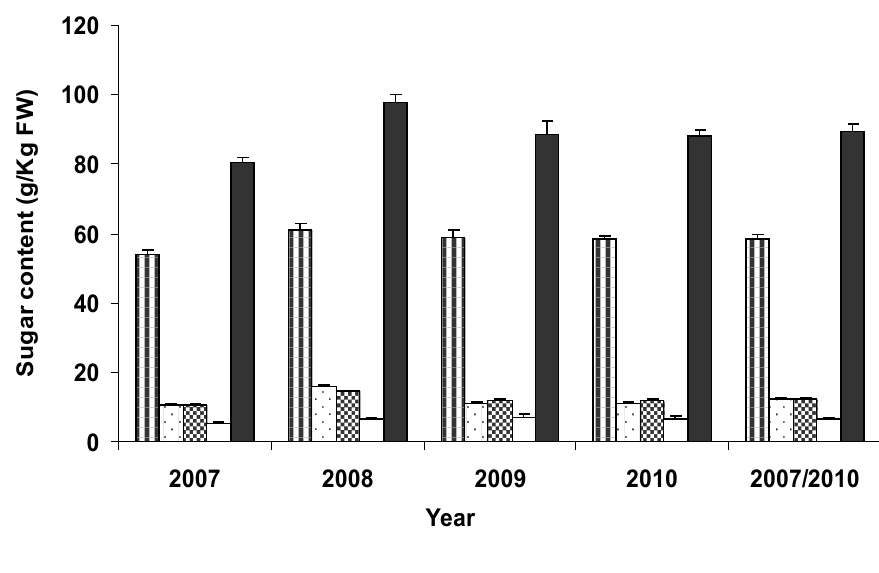
Figure 2. Annual amounts of sugar compounds (g per kg of FW) in the “Venus” × “Big Top” progeny. Data are means ± SE of four years of study (2007–2010) ( n = 42–75